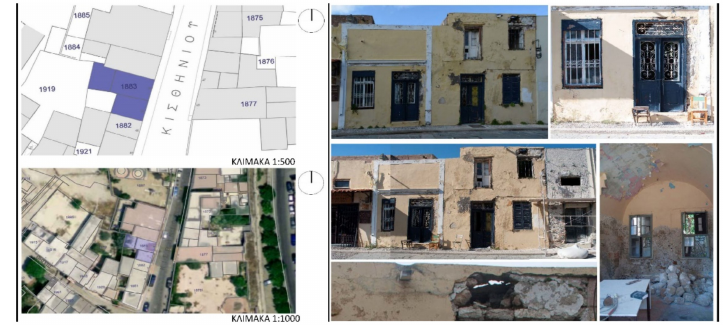
Figure 23. Kisthiniou 38–40 (listed building—evaluation sheet).